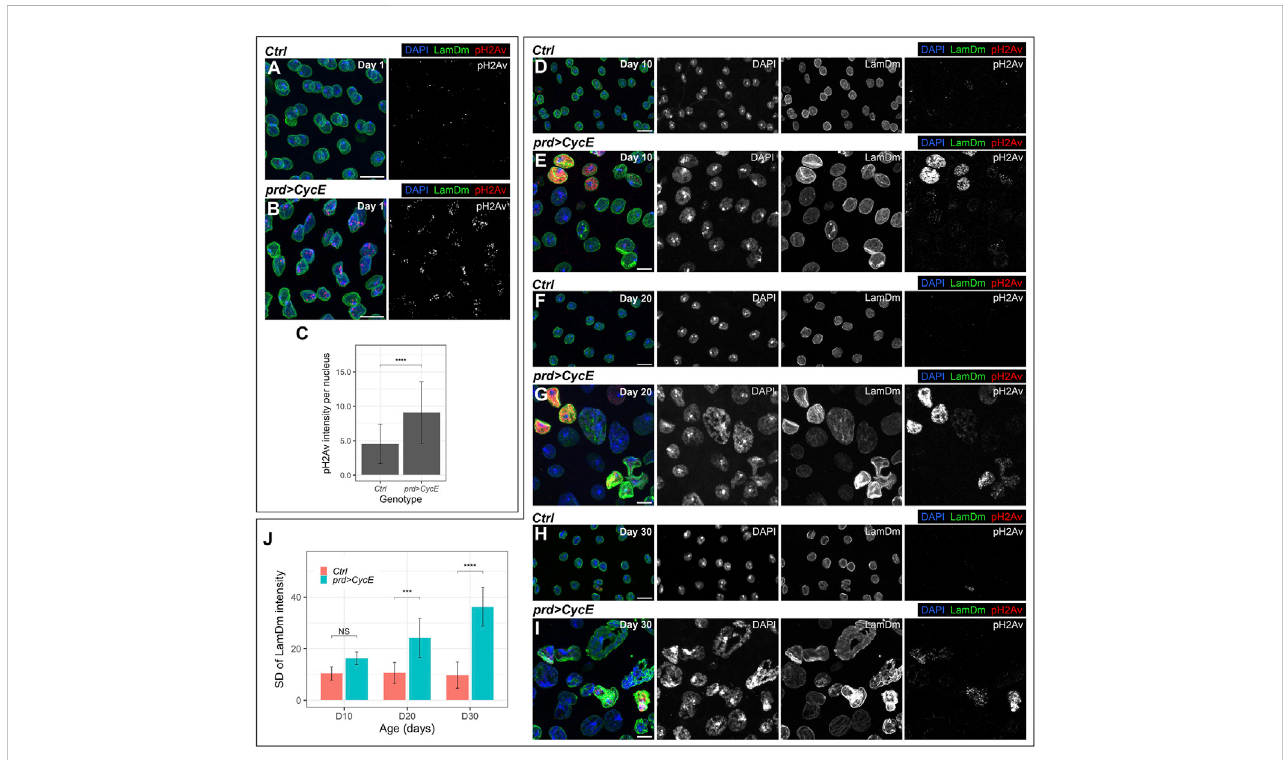
FIGURE 3 Cyclin E-drivenDNAdamage and genomic instability. (A – C) Confocalimages of1-day-old control ( prd-Gal4/+ ) (A) and prd > CycE (B) accessoryglands stained with anti-Lamin Dm and anti-pH2Av, and the corresponding pH2Av intensity quanti fi cation (C) . In (A,B) , DAPI, LamDm and pH2Av are shown in blue, green,andred,respectively. Datashownin (C) aremean±SD.Statisticalanalysis wasperformedusingaMann-Whitneytestfor unpaireddata.****, p < .0001. Scale bars, 10 µm. (D – I) Confocalimagesof 10-day-old, 20-day-old and 30-day-old control ( prd-Gal4/+ ) [ (D,F,H) , respectively] and prd > CycE [ (E,G,I) , respectively] accessory glands labeled with anti-Lamin Dm and pH2Av. DAPI, LamDm and pH2Av are shown in blue, green, and red, respectively. Scale bars, 10 µm. (J) Quanti fi cationofthestandarddeviationofLaminDmintensityofcontrol( prd-Gal4/+ )and prd > CycE glandsatdays10,20,and30.Datashownare mean ± SD. Statistical analysis was performed using a two-way ANOVA followed by a Tukey ’ s HSD test. Only the relevant signi fi cant changes are shown. NS, non-signi fi cant. ***, p < .001, ****, p <